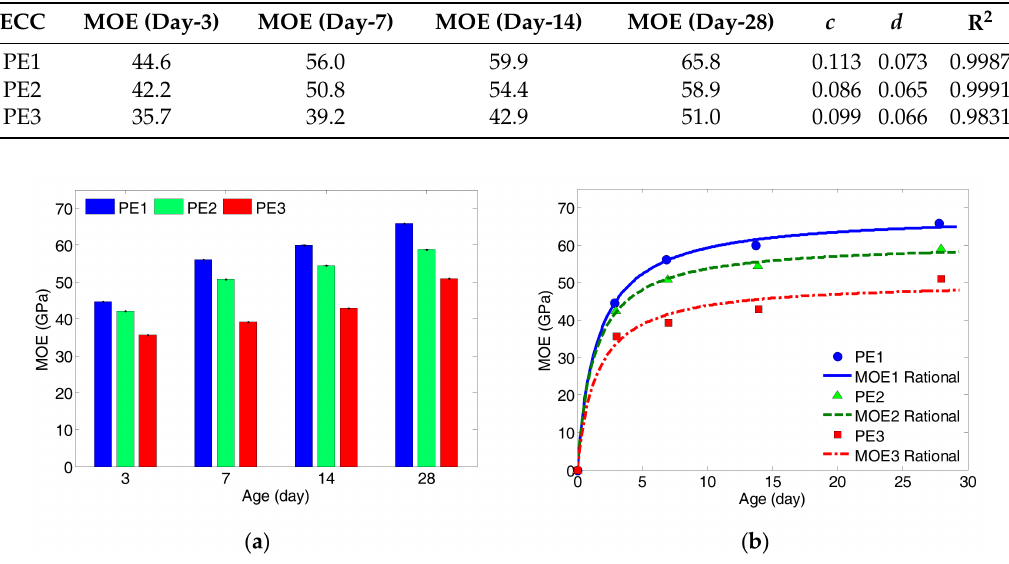
Figure 8. ( a ) Measured single values of MOE; ( b ) regression for measured data by first-order rational